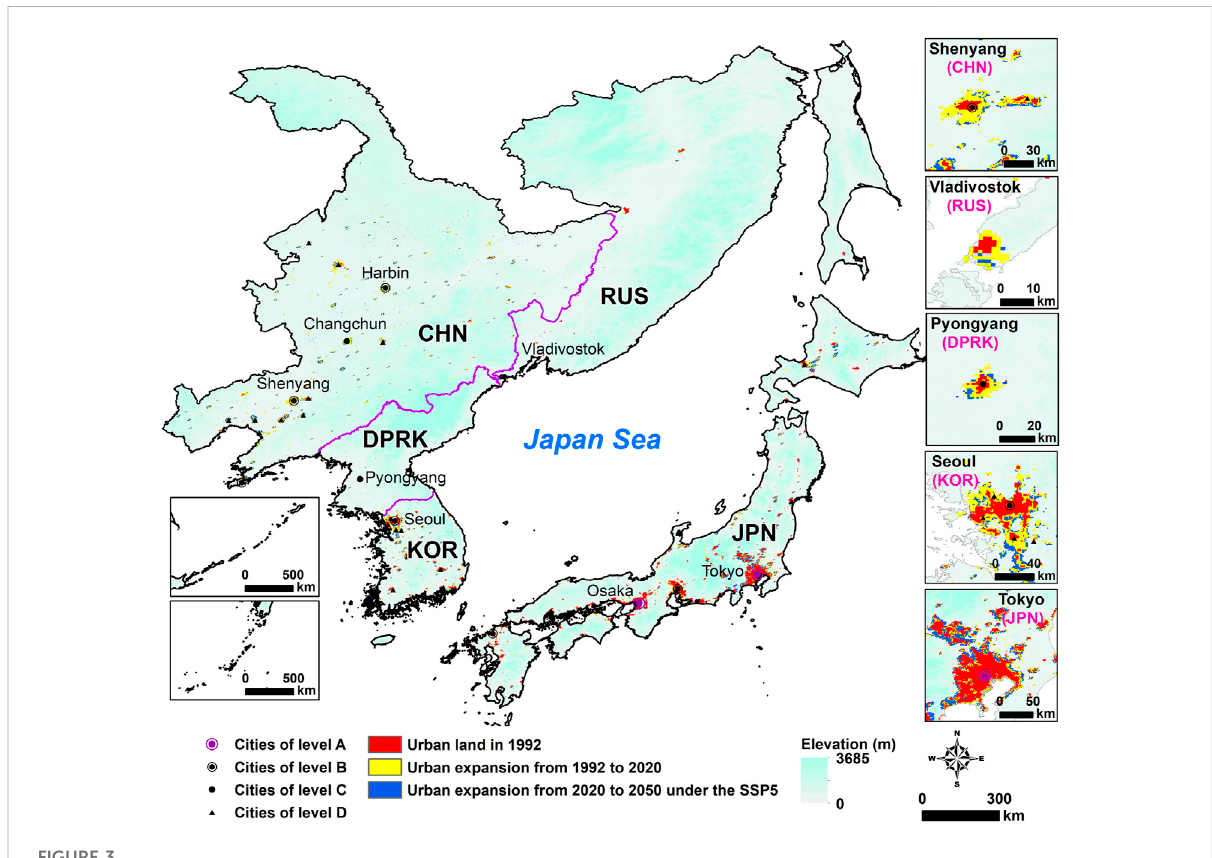
FIGURE 3 Urban expansion in the JSR under the SSP5 from 1992 to 2050.